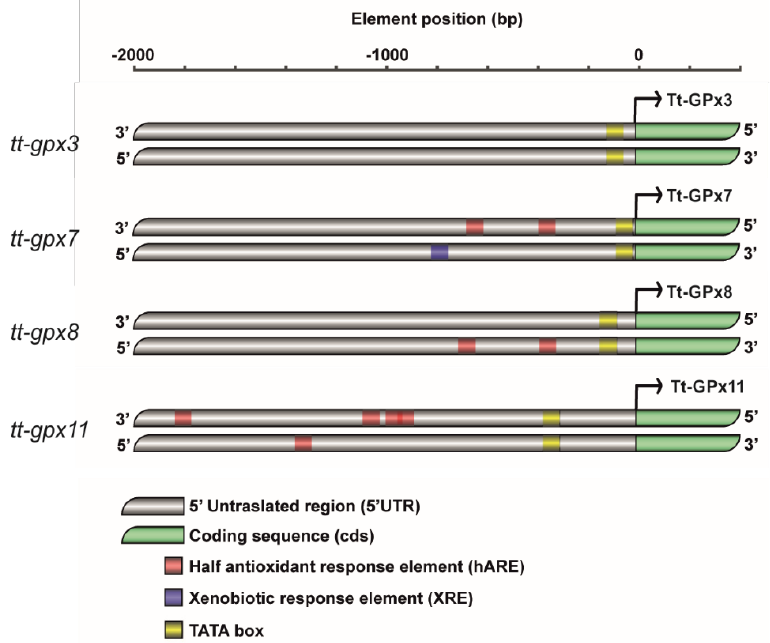
Figure 1. Arrangement of putative half antioxidant responsive element (hARE) and xenobiotic responsive element (XRE) in upstream regions of tt-gpx11 , tt-gpx3 , tt-gpx8 , and tt-gpx7 genes. hAREs carrying consensus sequences are indicated by red blocks, XRE and TATA-box consensus sequences are annotated as filled blue and black blocks, respectively. Transcription start site is indicated by an arrow. jModelTest 2.0 software indicated that the GTR + I + G model is the best-fit model to analyze